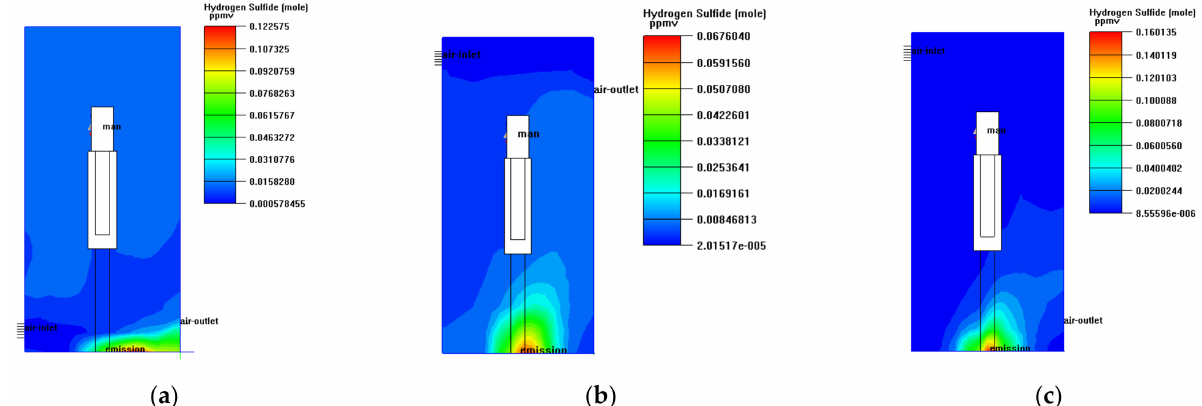
Figure 13. Concentration distribution of H 2 S in different ventilations: down-supply and down- exhaust, up-supply and up-exhaust, up-supply and down-exhaust, respectively. ( a – c ): Pollution distribution at X = 0.55 m.